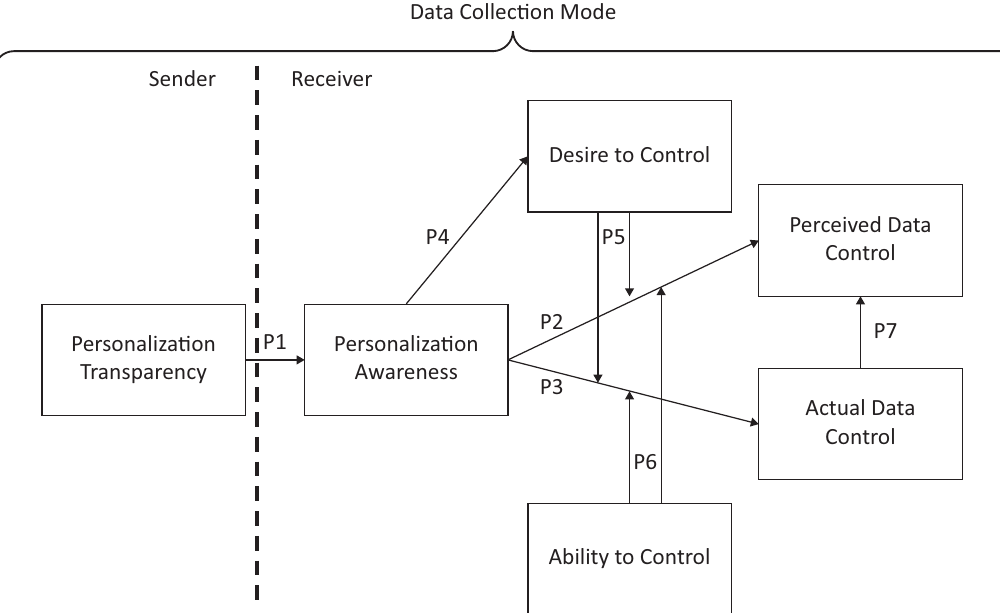
Figure 2. Transparency–awareness–control framework.